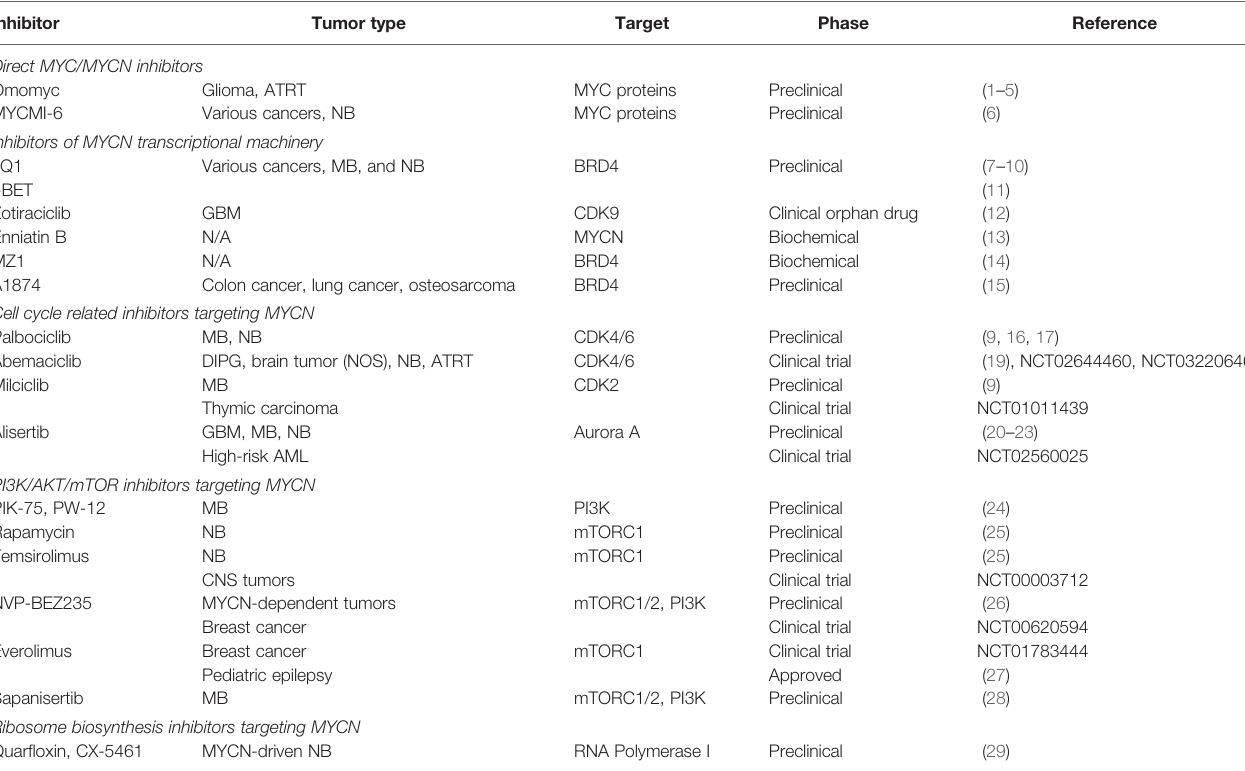
TABLE 1 | Drugs and compounds for targeting of MYCN